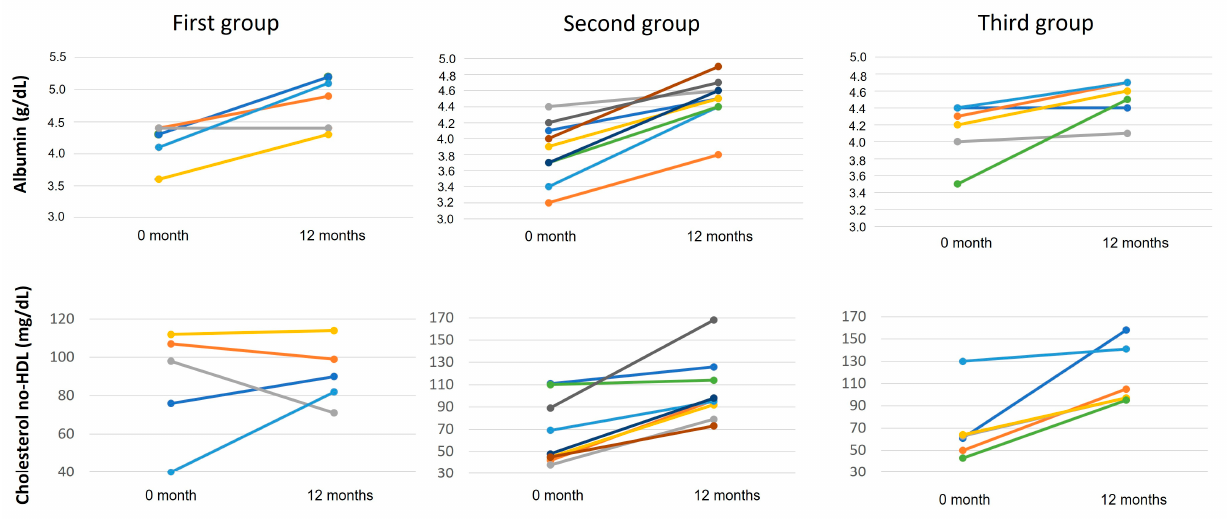
Figure 1. Serum albumin and non-HDL cholesterol trend in CF patients at baseline and 1 year of ETI therapy. The groups have been subdivided as described in Table 1.